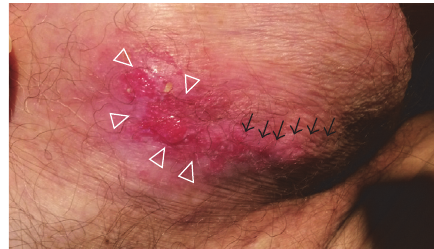
Figure 3: Macroscopic image of the scrotum. The arrows show the incision of the previous surgical treatment. The arrowheads show the area of local recurrence.